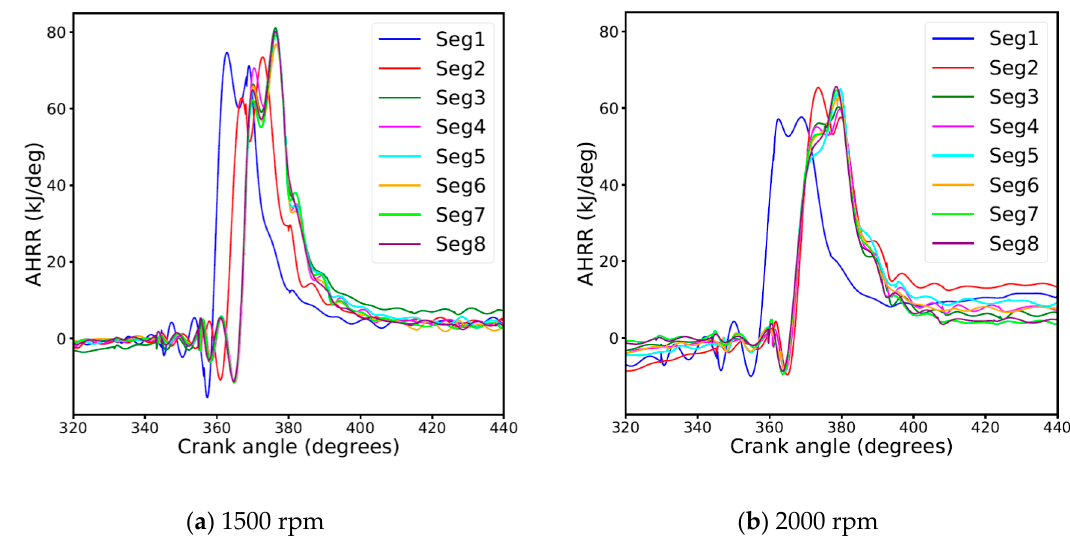
Figure 8. AHRR at 25% load in each segment in all stages at ( a ) 1500 rpm and ( b ) 2000 rpm. The blue line represents Segment 1, red line represents Segment 2, green line represents Segment 3, magenta line represents Segment 4, cyan line represents Segment 5, orange line represents Segment 6, lime line represents Segment 7 and purple line represents Segment 8.